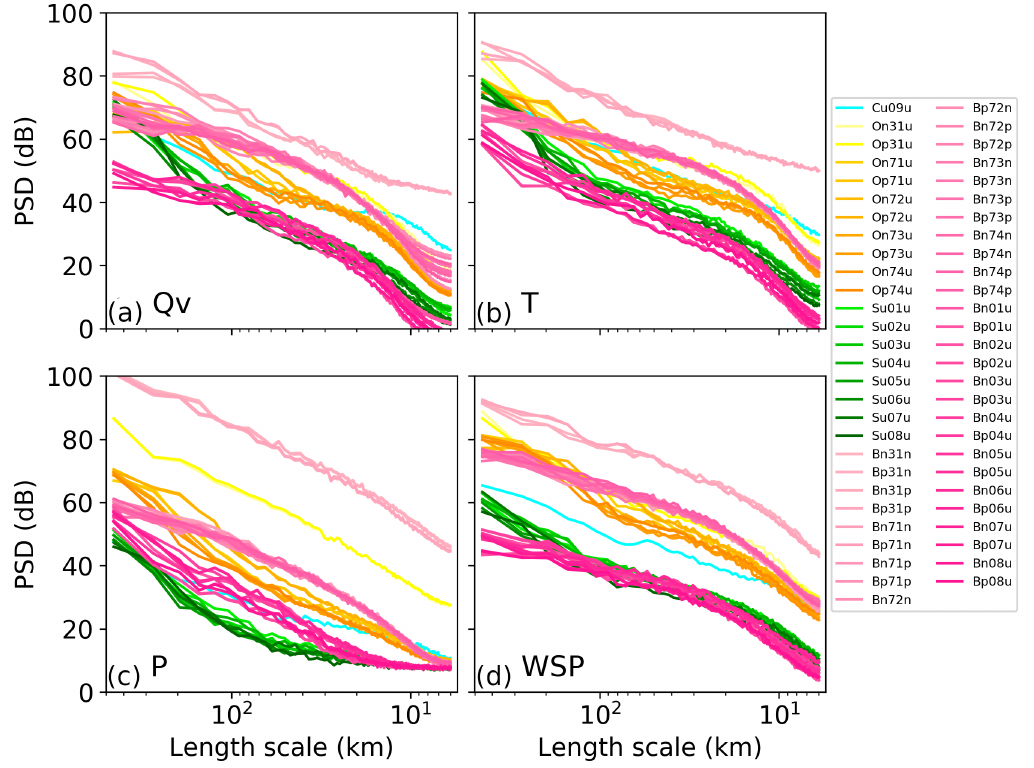
Figure 5. 1-D power spectral density in dB of the water vapor ( a ), temperature ( b ), pressure ( c ), and wind speed ( d ) perturbation fields in the sigma level closest to the surface at 00Z on 27 February 2017 for each member of the ensemble system. The frequency domain (horizontal axis) is expressed in terms of distance in